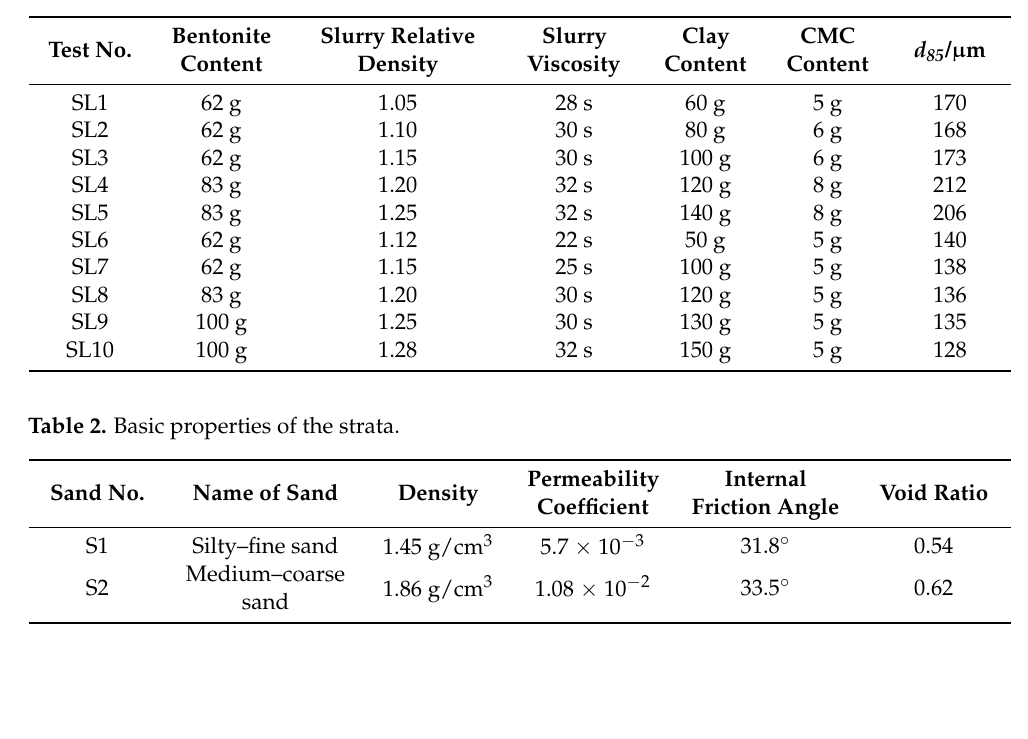
Figure 3. The ten groups of slurry samples used for testing. Table 1. Physical parameters of the testing slurry.